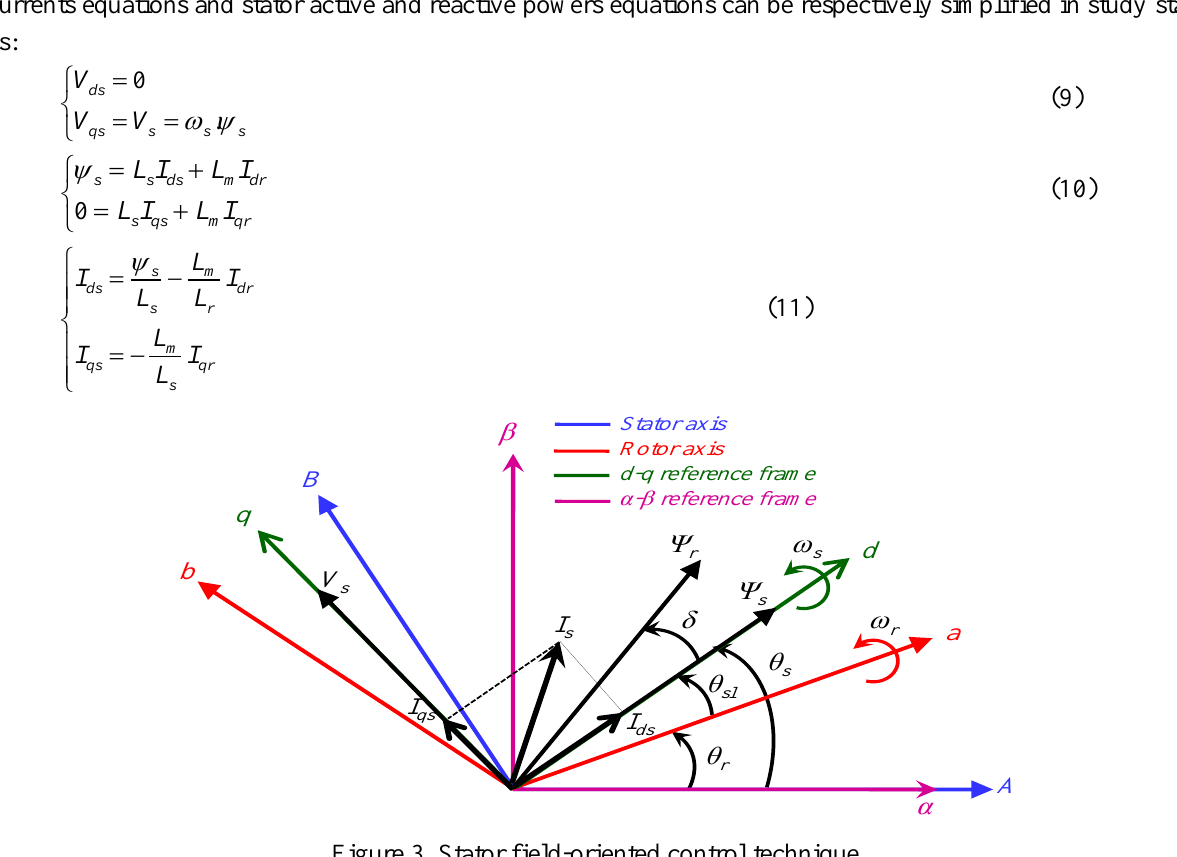
Figure 3. Stator field-oriented control